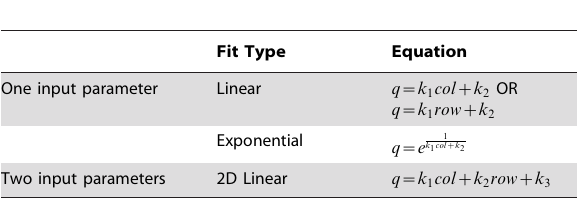
Table 4. Functions for the idealized whisker array.